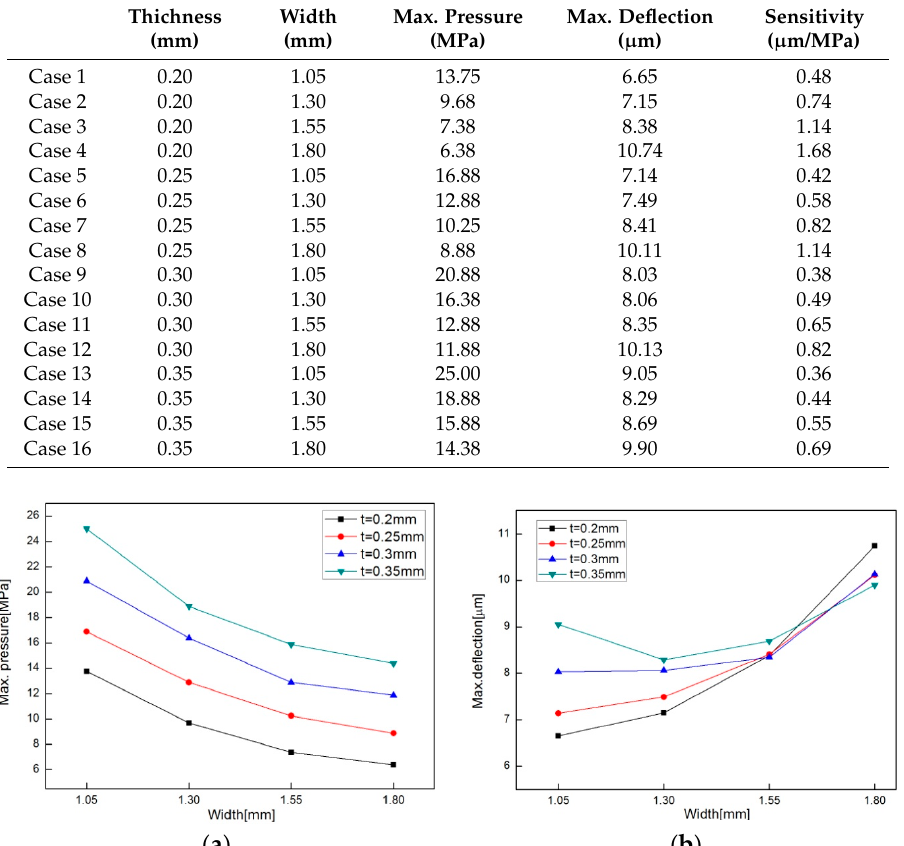
Table 1. 16 cases of properly selected design parameters with analytical results of maximum pressure, maximum deflection and sensitivity.